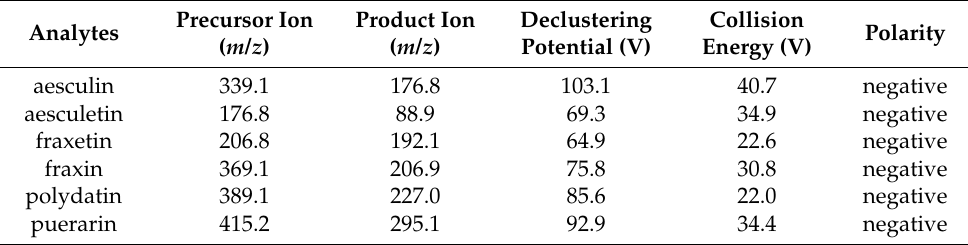
Figure 1. Chemical structures and product ion mass spectra of analytes and IS. ( A ): aesculin; ( B ): aesculetin; ( C ) : fraxetin; ( D ): fraxin; ( E ) : polydatin; ( F ): puerarin. Table 1. Optimized mass spectrometric parameters for analytes and IS.